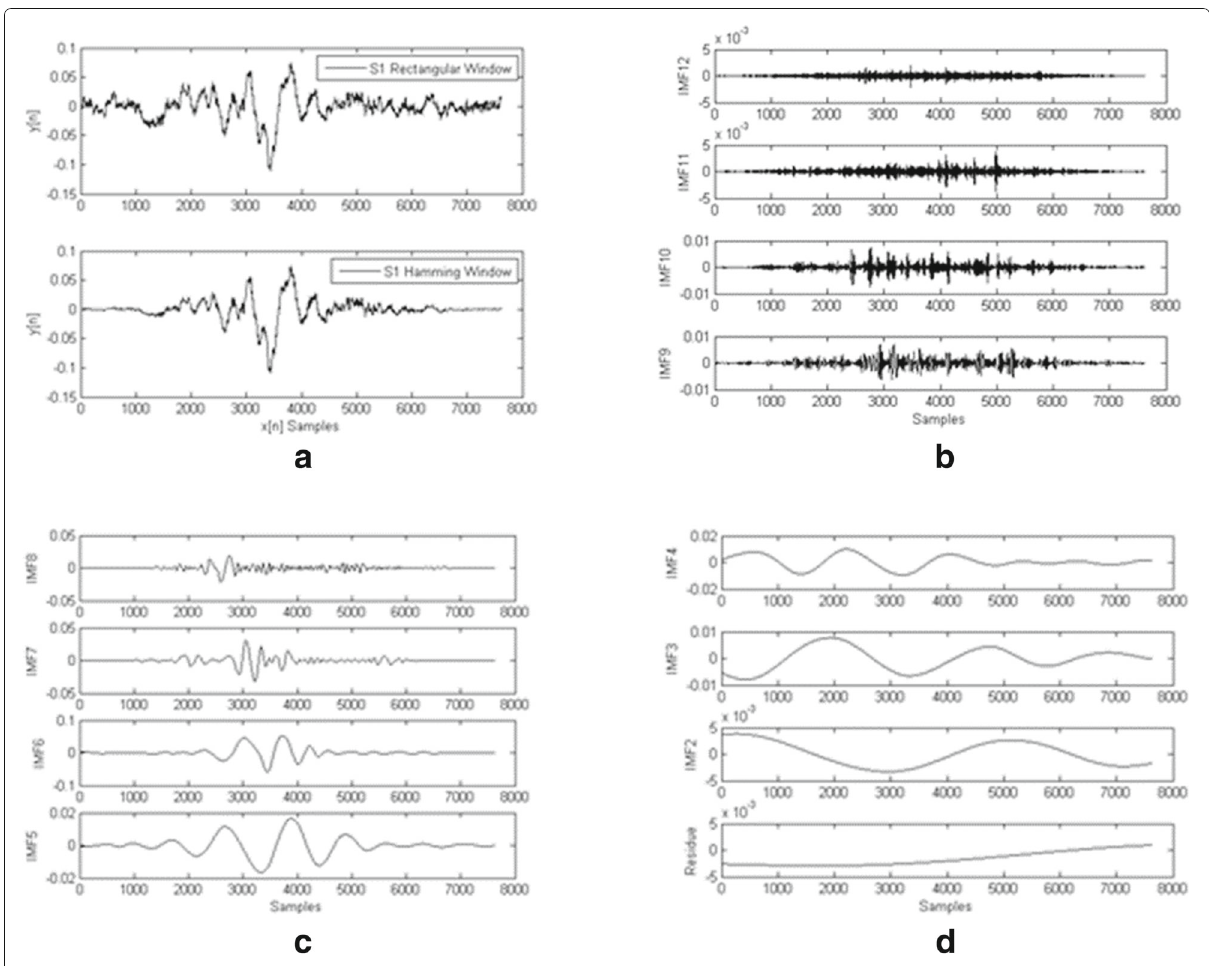
Fig. 10 EMD-based low-, mid-band, and high-frequency extraction of a sample S1 beat . a S1 heart beat signal extracted using rectangular and hamming window. b S1 heart beat: high-frequency component extracted using EMD transform. c S1 heart beat: mid-band frequency component extracted using EMD transform. d S1 heart beat: low-frequency component extracted using EMD